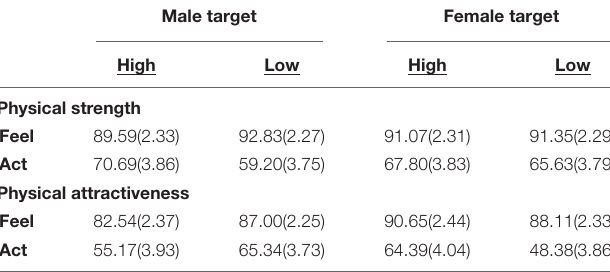
TABLE 1 | Means ( SE s) of expected levels of anger display from different targets.